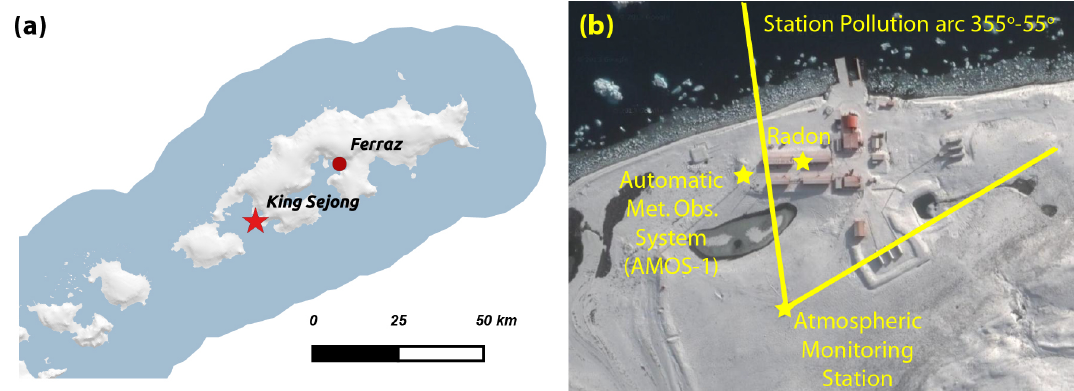
Figure 2. (a) Location of King Sejong Station on King George Island at the tip of the Antarctic Peninsula, and (b) the relative location of KSG radon observations, meteorological observations (automatic meteorological observation system #1), the atmospheric monitoring station and the excluded station sector (355–55 ◦ ).